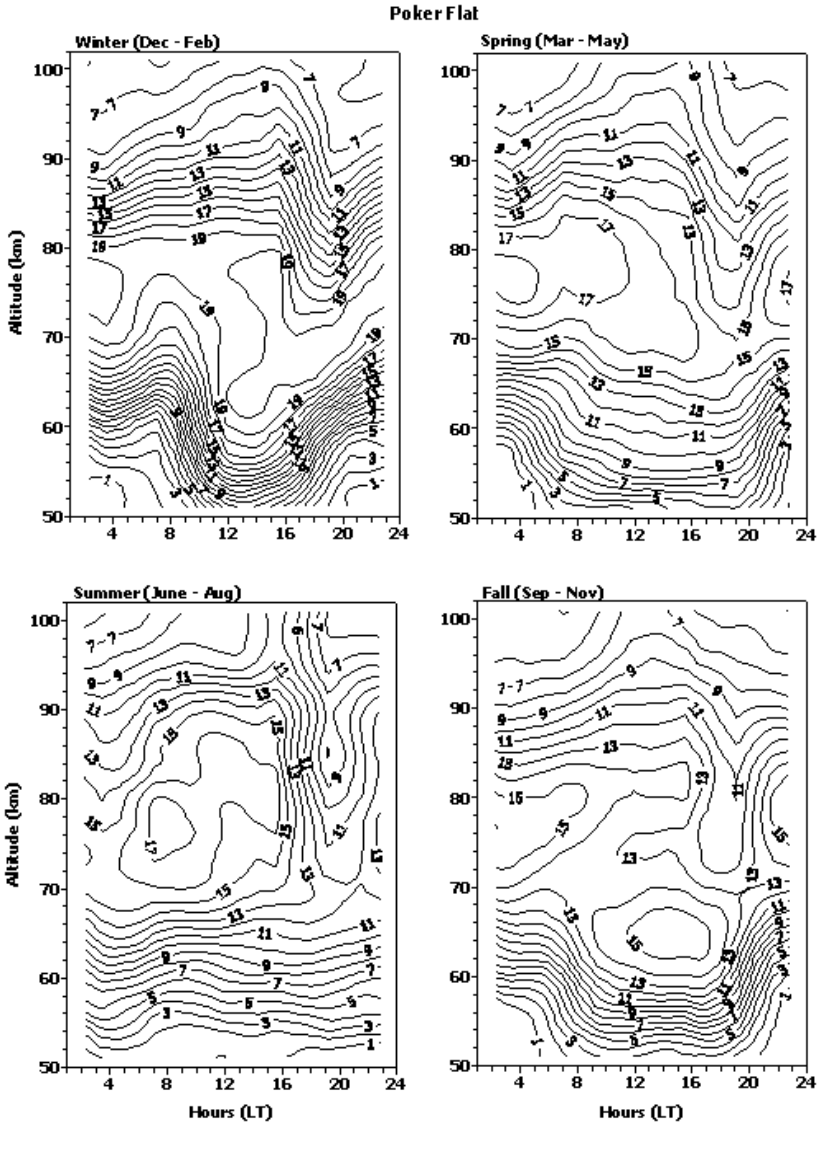
Fig. 1. Average number of wind esti- mates available per hour at each height gate (between 50 and 100km) for sum- mer, winter, spring, and fall seasons during 1999. Maximum number possi- ble is 20 estimates/hour.